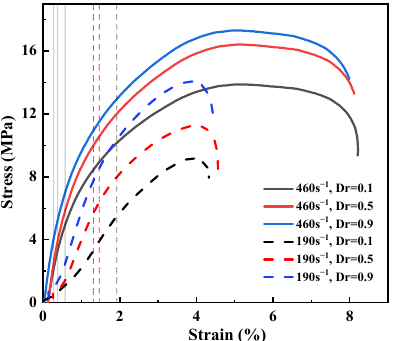
Figure 17. Dynamic stress–strain curves of sand specimens with different relative densities.